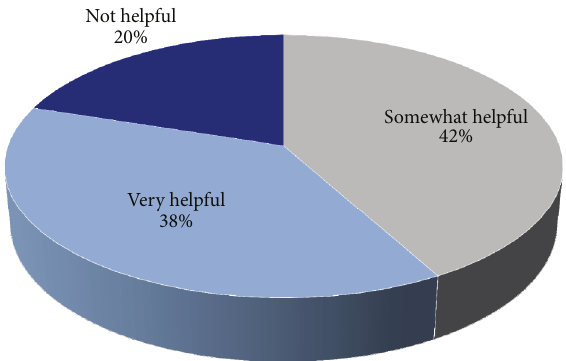
Figure 3: Distribution of the percentages of anesthesia departments finding perioperative guidelines for management of the cocaine abusing patients